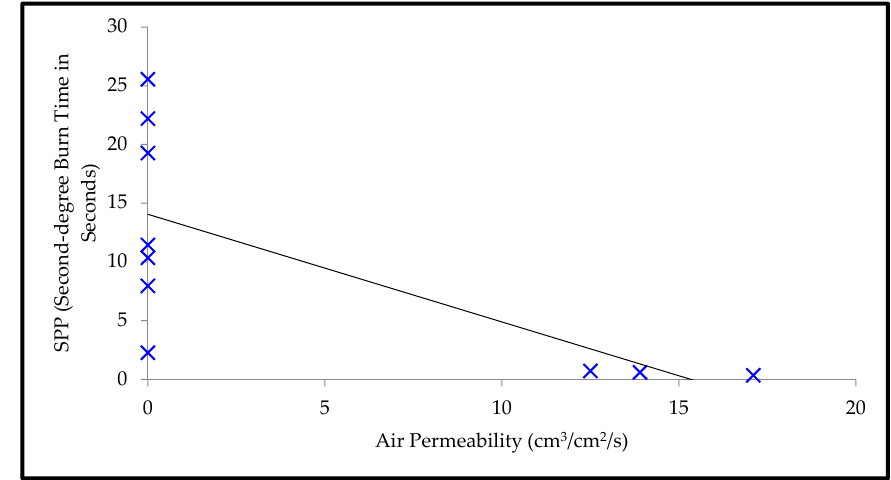
Figure 8. Relationship plot of air permeability and SPP.